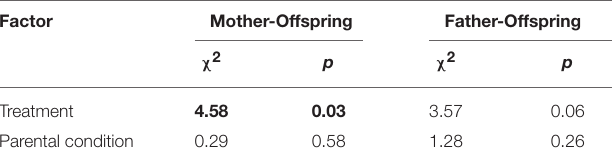
TABLE 1 | Output from models testing for differences in parent-offspring association in Liopholis whitii between treatments and in relation to parental condition.